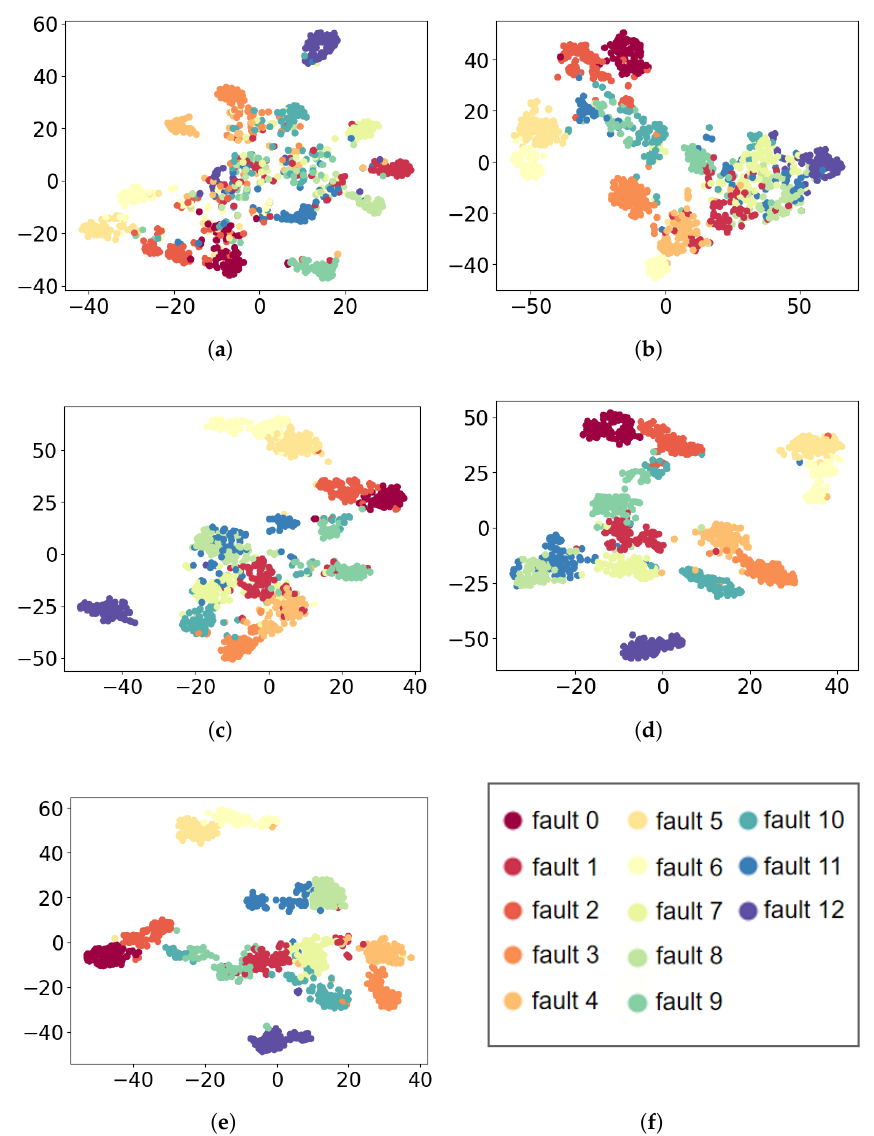
Figure 8. Feature visualization via t-SNE: PU dataset. ( a ) MLP; ( b ) CNN; ( c ) SimpleIMSCNN; ( d ) MSCNN; ( e ) IMSCNN; ( f ) class of the each